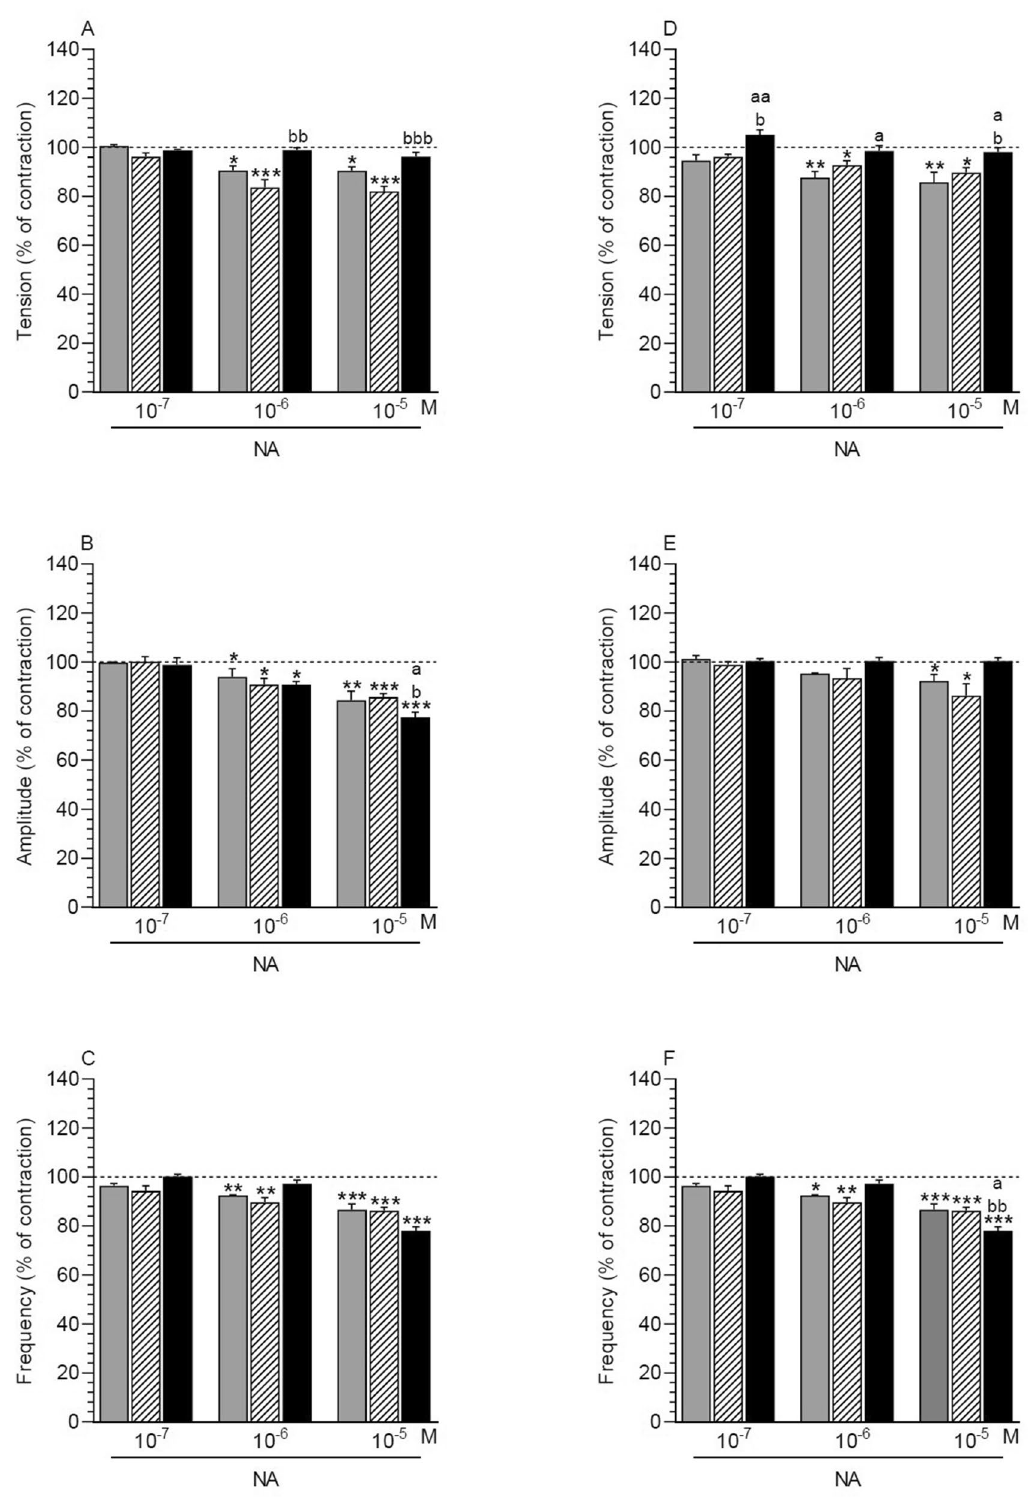
Figure 1. Effect of noradrenaline (NA) on the tension ( A , D ), amplitude ( B , E ) and frequency ( C , F ) of contraction in myometrium ( A – C ) and endometrium/myometrium ( D – F ) strips of gilts from the CON (grey bars), SAL (hatched bars) and E. coli (black bars) groups. Data obtained from five experiments (gilts, in each group). Effects of particular doses of NA are presented as a percentage (mean ± SEM) in relation to the basal (pre-treatment period) tension, amplitude and frequency, accepted as 100% (horizontal lines). *P < 0.05, **P < 0.01, ***P < 0.001—indicate differences in the comparison to the basal value in each group; a P < 0.05— indicates a difference between the CON and E. coli groups for the same treatment; b P < 0.05, bb P < 0.01, bbb P < 0.001—indicate differences between the SAL and E. coli groups for the same